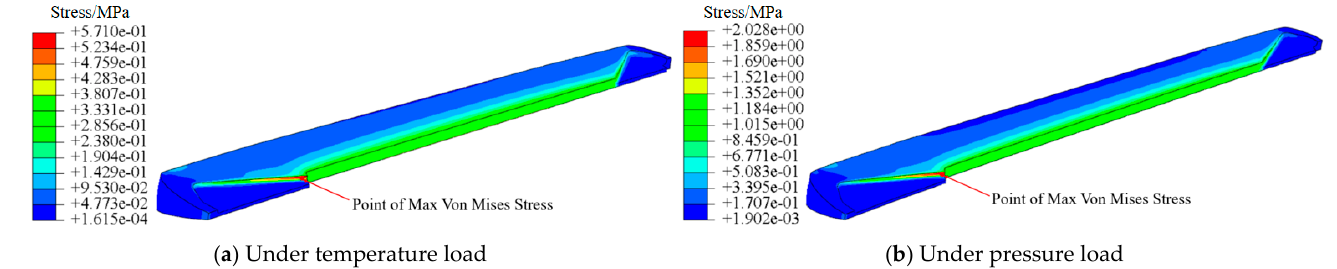
Figure 7. Von Mises stress cloud of the grain under different load.